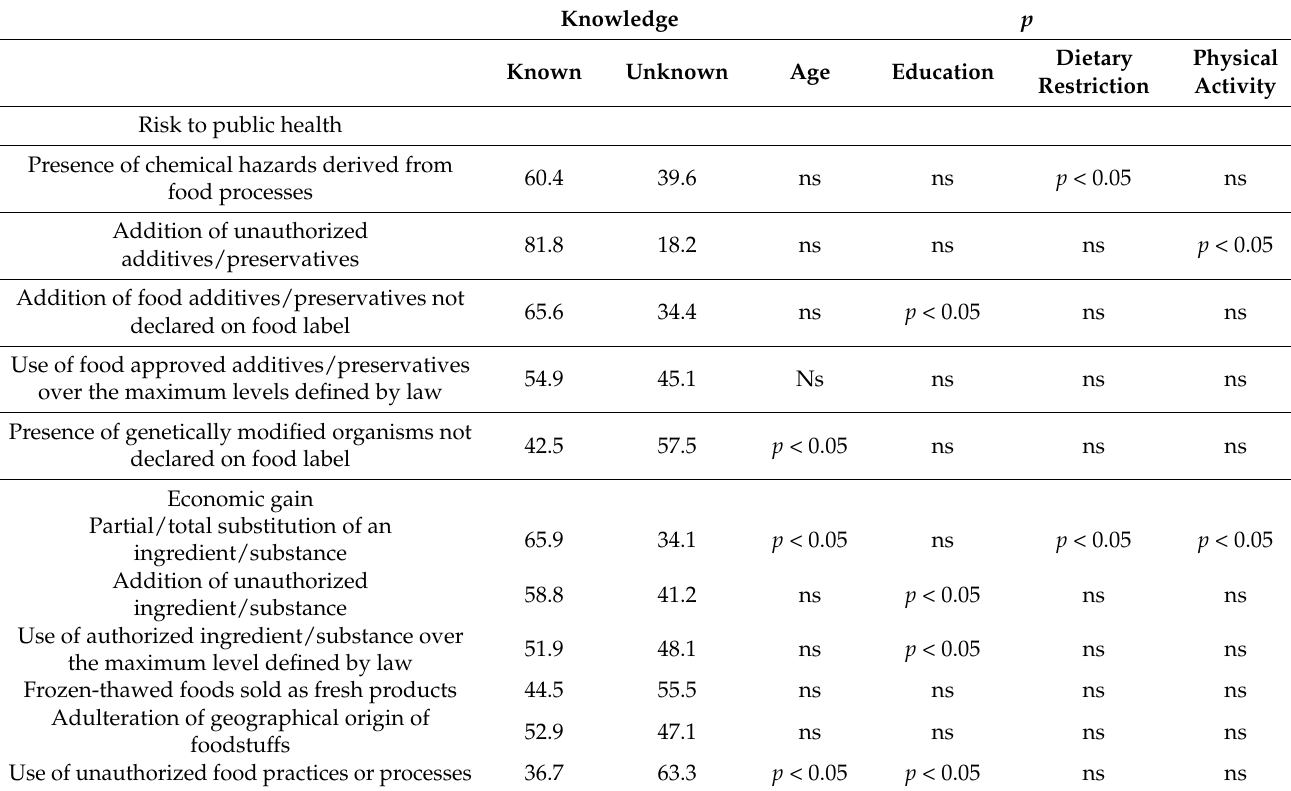
Table 3. Respondents’ knowledge about food fraud and socio-demographic factors influenced knowledge.